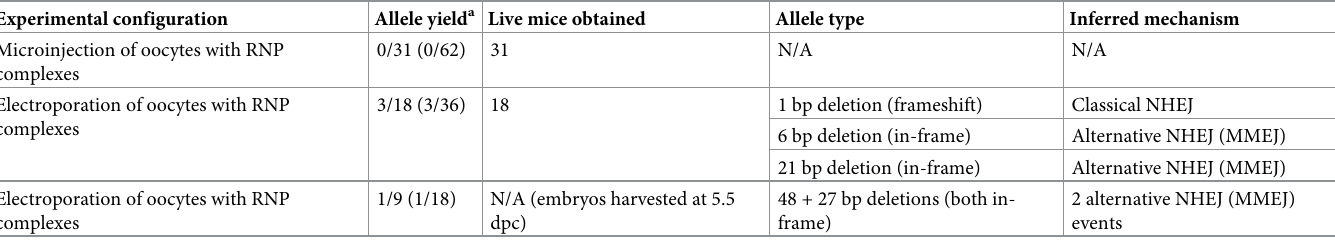
Table 1. Summary of gene editing